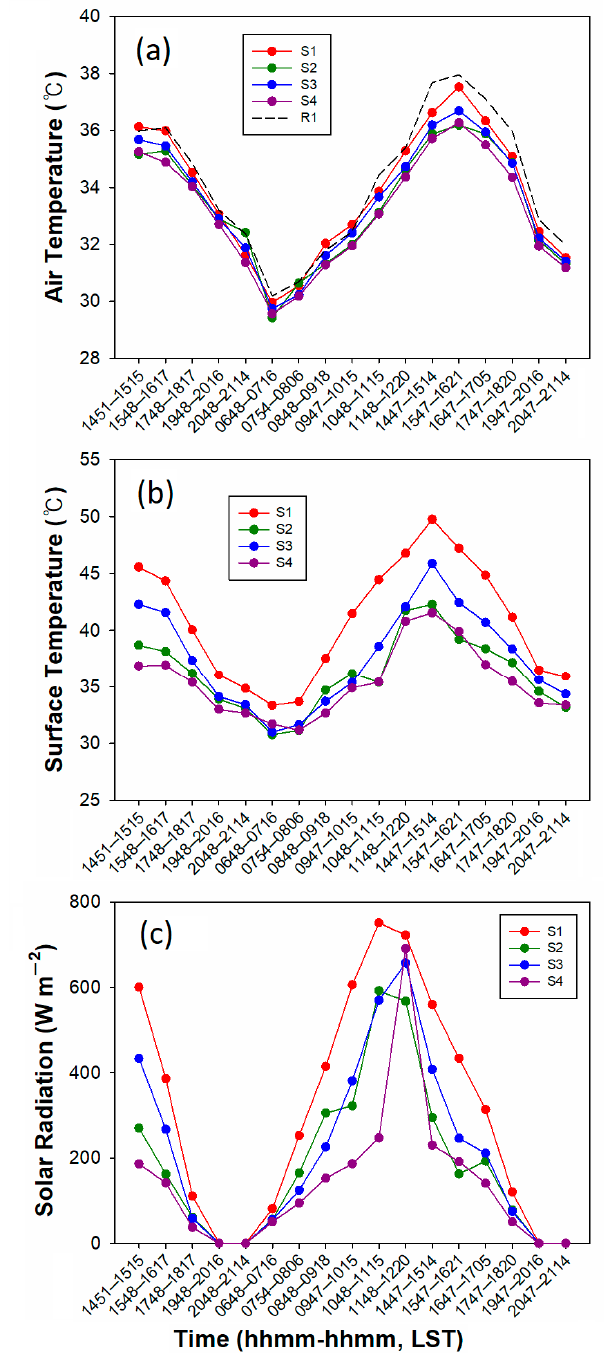
Figure 10. Diurnal variations of ( a ) air temperature, ( b ) road surface temperature (RST) and ( c ) solar radiation for the different sections. R1 with black dashed line in Figure 10a denotes air temperature of reference site.